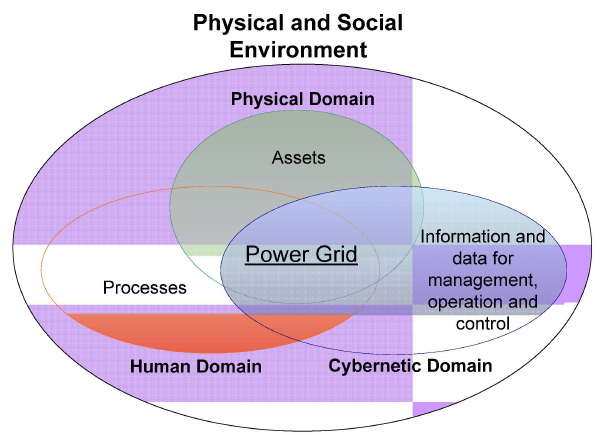
Figure 3. The three main components of a power grid as a human-cyber-physical